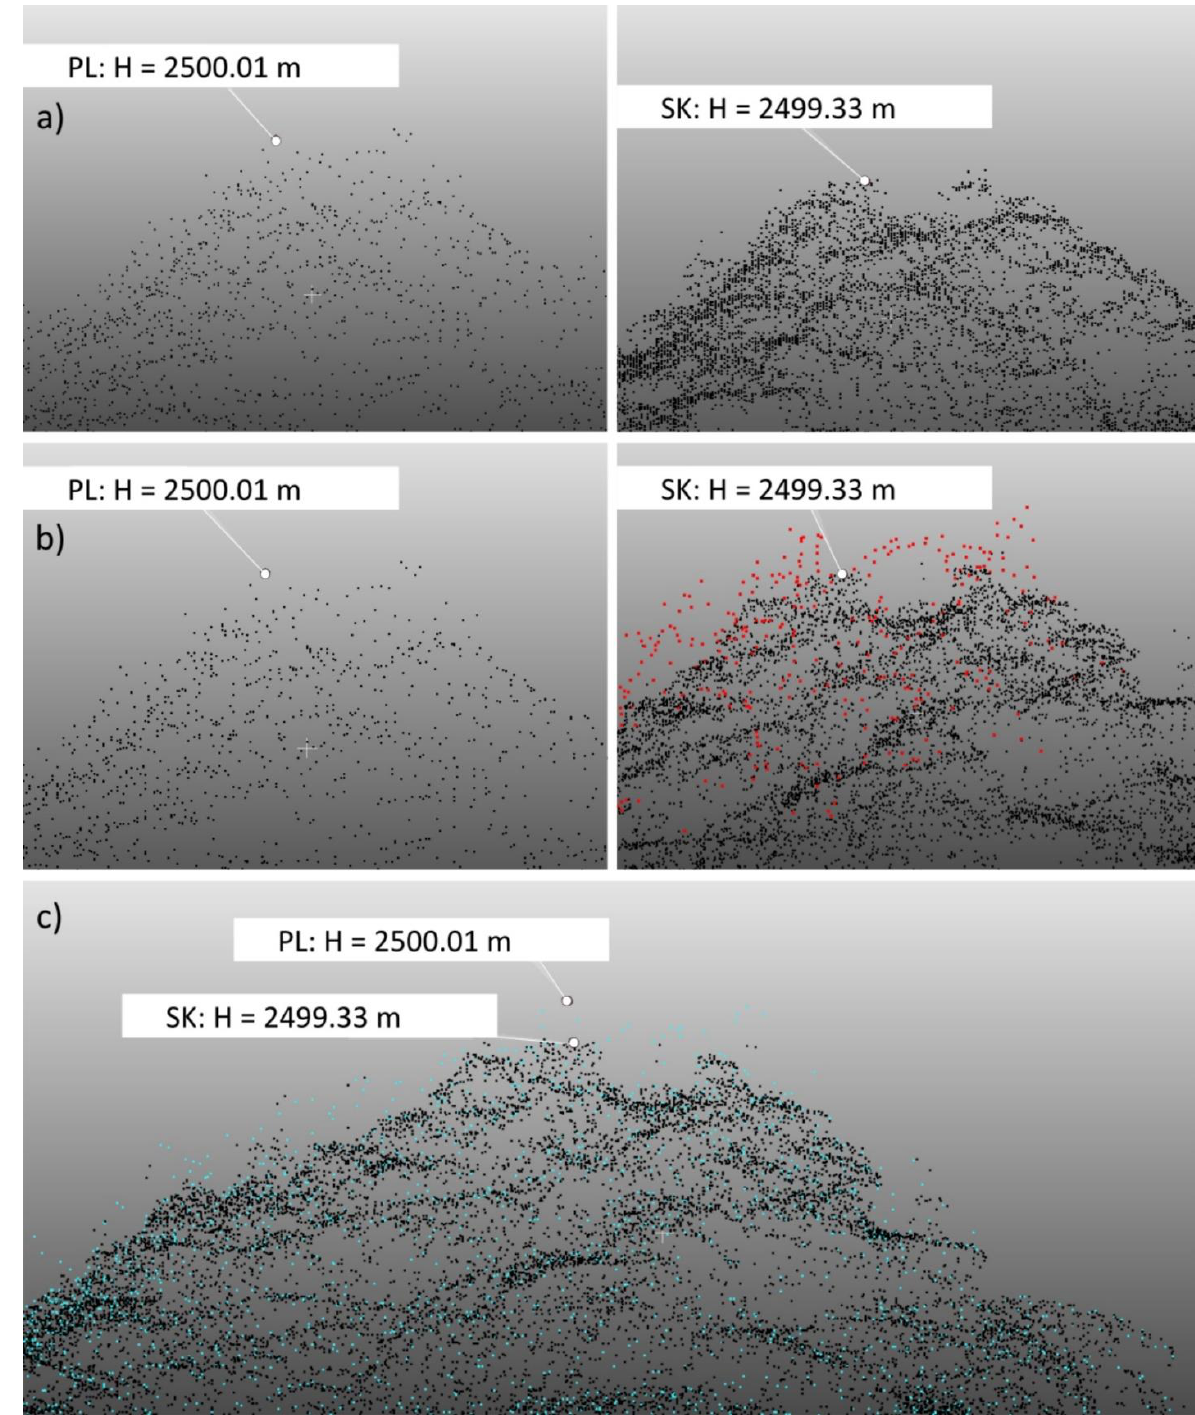
Figure 4. ( a ) The highest point on Rysy and Ground class, ( b ) the highest point at the peak and all other classes (black—Ground, red—others), ( c ) Polish (blue) and Slovak (black) datasets, Ground class. Source: